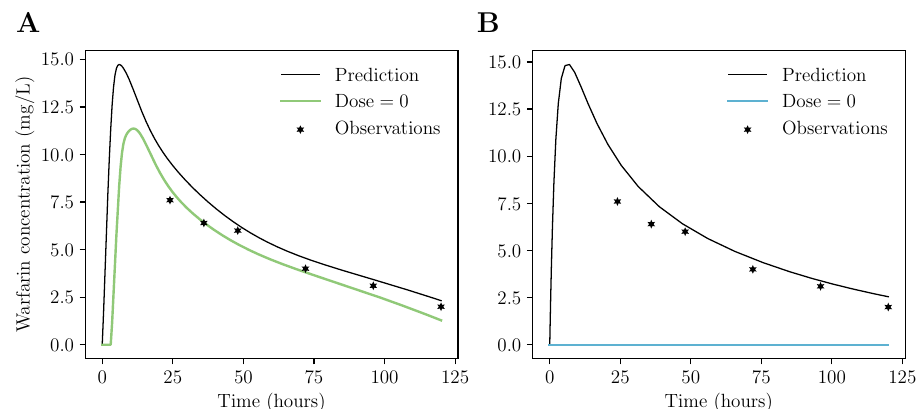
Figure 2. Examples of predicting drug concentrations using neural networks. Concentration-time curves for a single test set patient are shown as predicted using naive ( A ) and ODE-based ( B ) neural networks. Model prediction when artificially setting the dose to zero is depicted by the colored lines. Stars represent the measured warfarin concentrations for the